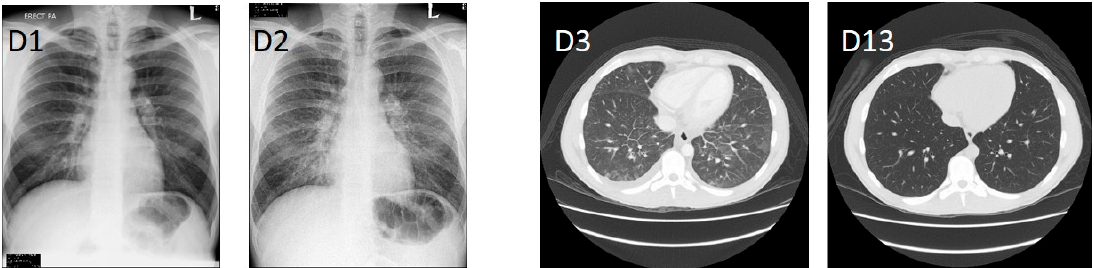
Figure 1. Chest X-rays upon admission (D1) and subsequent day (D2). Contrast-enhanced CT scan after oral and intravenous contrast administration at the day of hypotensive shock (D3), and post-treatment (D13).